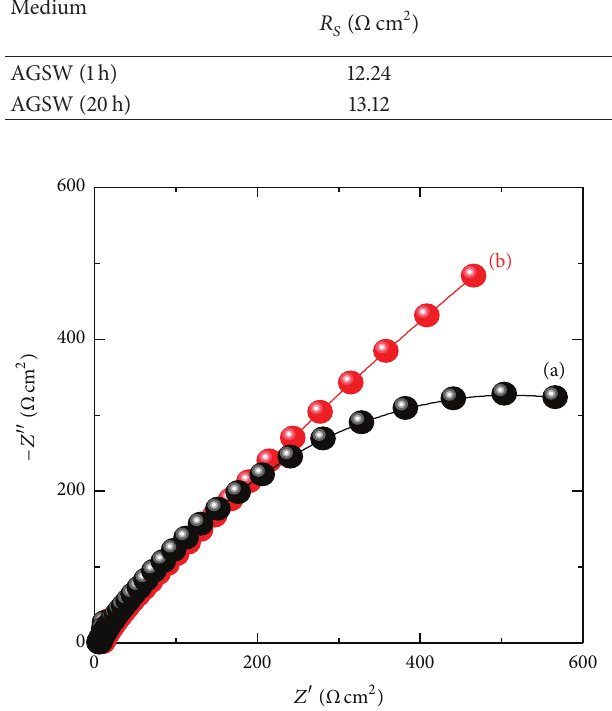
Figure 2: EIS Nyquist plots obtained for the API X70 pipeline steel after its immersion for (a) 1h and (b) 20 h in Arabian Gulf seawater.